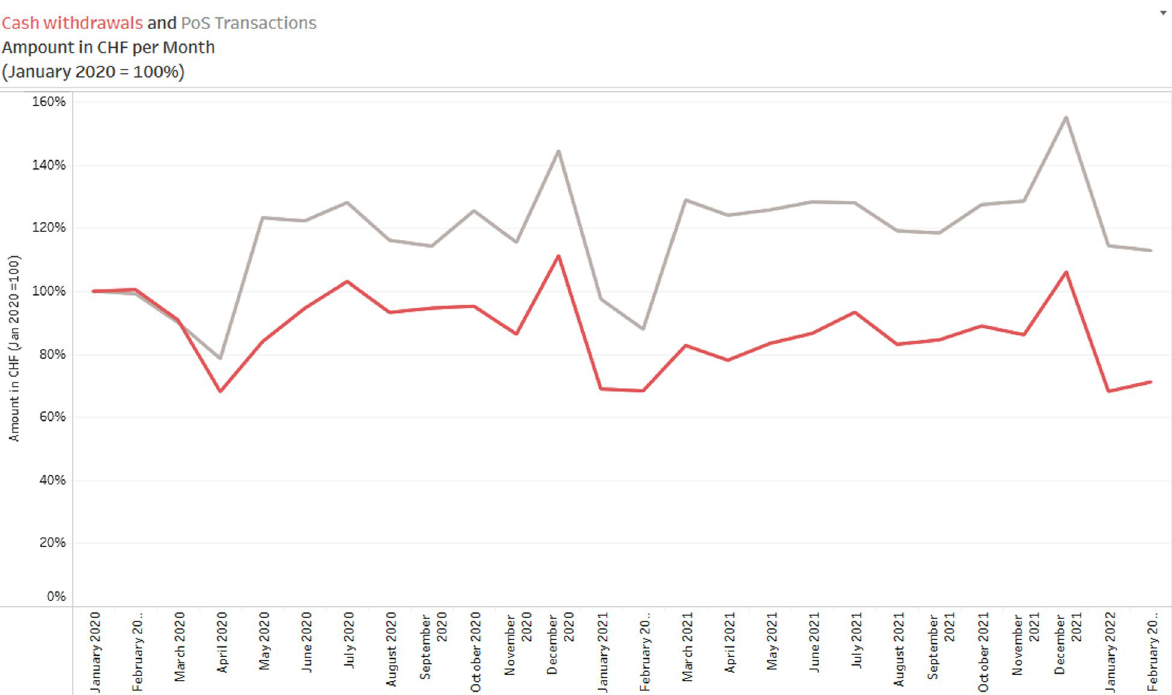
Fig. 11 Debit cards: ATM withdrawals vs. PoS transactions. Note : The figure displays monthly spending (in CHF) with debit cards issued by Swiss banks for 2020.01–2022.02 from the project data. Spending at PoS terminals is displayed in gray, cash withdrawals from ATMs are displayed in red. Cash withdrawal transactions are based on a constant population of ATMs, which report all transactions of own-bank and other-bank clients from 2020.01. See Sect. 5 for details. Data source: ATM_Canton.csv, Debit_Canton.csv